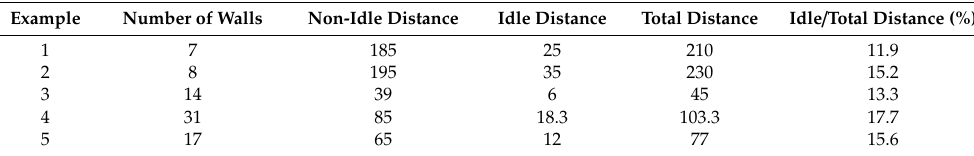
Figure 13. Comparison of idle to total distances. Table 14. Comparison of distances for the examples